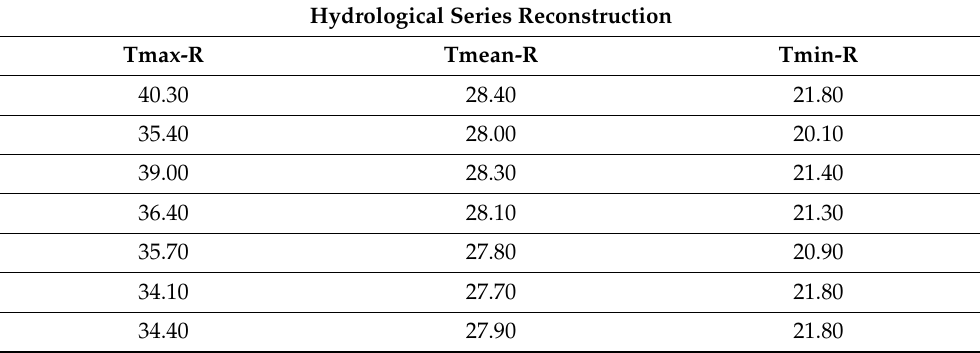
Table A4. The series corrected for homogeneity are called corrected maximum temperature (Tmax-R), corrected4mean temperature (Tmean-R), and corrected minimum temperature